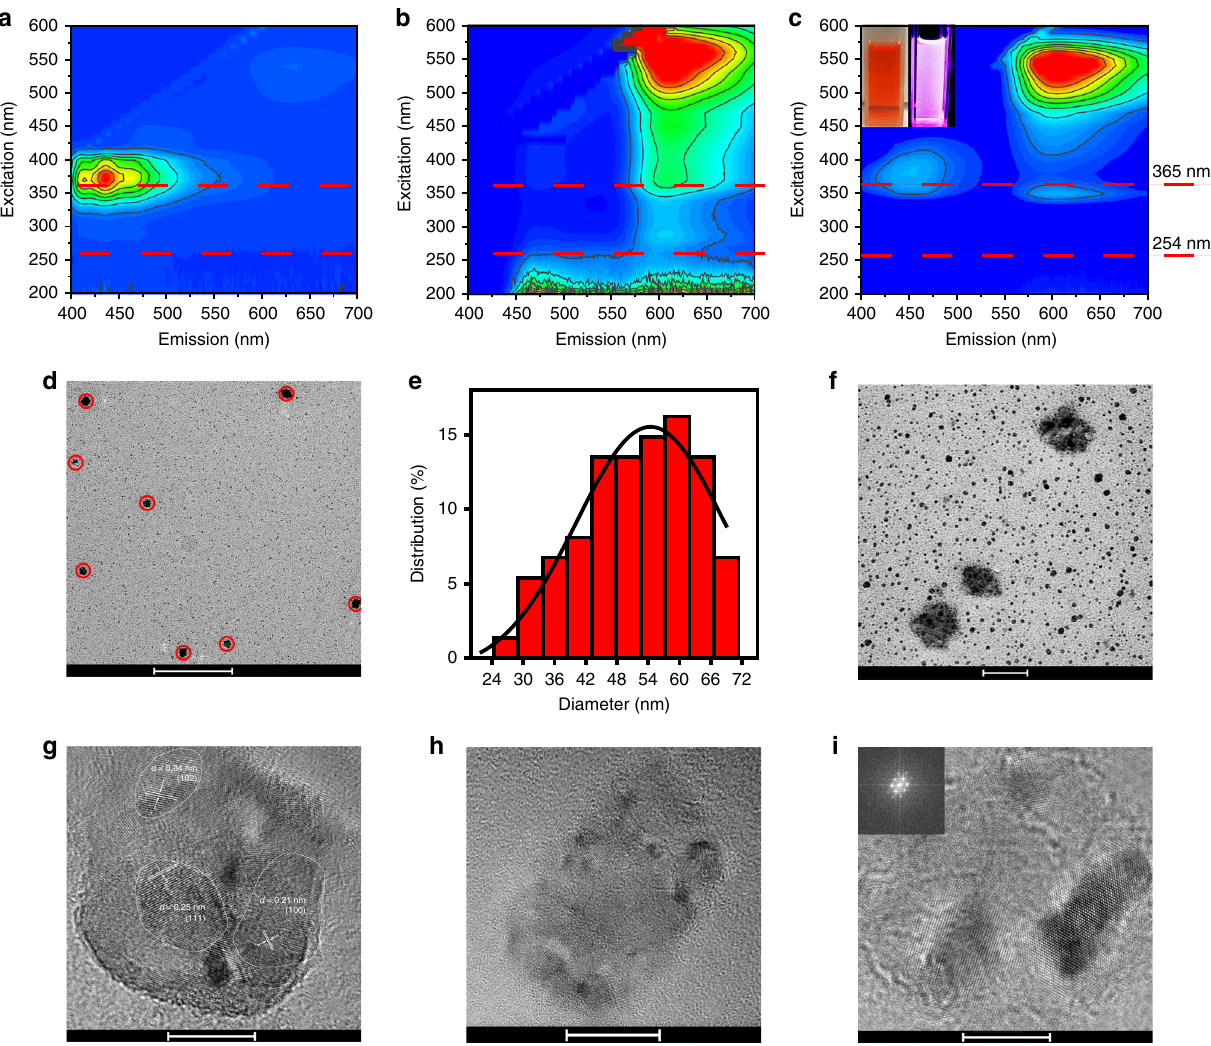
Fig. 5 Different fl uorescence and morphology of H-CDs in varying state. PL mapping spectra of a the H-CD powder acetic acid solution, b H-CD powder and c the H-CD powder DMF solution (insets: photos of the H-CD DMF solution under white light (left) and 365 nm (right) irradiation, dash line marks out emission under 365 or 254 nm UV). d , f TEM image and e particles size distribution of H-CD aggregates (marked by red circles) in the DMF solution. g – i High-resolution TEM (HR-TEM) image of the H-CD aggregates in the DMF solution, inset: FFT diffraction pattern of carbon lattice. Scale bars: 500 nm ( d ), 50 nm ( f ), 20 nm ( h ) and 10 nm ( g , i ). H-CD, hydrophobic carbon dot, TEM transmission emission axisymmetric heterocycles shown in Supplementary Fig. 2 suffer from the restriction of intramolecular rotation (RIR) of symmetrical heterocycles about their disul fi de bonds axes, like other reported symmetrical molecules with AIE 17,18,50 , resulting in red AIE 15,16,51 . Fig. 6b. The square frames in Fig. 6b represent the fi lter paper, the wavy lines represent the paper ’ s fi bers. Blue dots represent the H- CD monomers dispersed in the fi lter paper due to the restriction of the paper ’ s fi bers. As mentioned above, H-CD monomers cannot be excited at 254 nm but can be excited at 365 nm. When water is introduced, some of the H-CD monomers aggregate and paper. Under white light, it is almost colorless and shows a blue fl uorescence under 365 nm UV excitation. At 254 nm the UV surface. Furthermore, the other monomers remain joint to the fi bers. Therefore, under 365 nm irradiation, both the monomers irradiation cannot produce any fl uorescence, which conforms to in the fi lter paper and the aggregates on surface can be excited to the PL property of the H-CD monomers shown in Fig. 5. By glow blue and red emission, which display as a hybrid pink adding water and air-drying, its fl uorescence under 365 nm UV fl uorescence. While under 254 nm irradiation, the monomers are turns to pink. Furthermore, it appears as a red fl uorescence, not excited further, resulting in the red emission only. Once which suggests the H-CDs on the fi lter paper contains both H-CD monomers and H-CD aggregates, compared with the former data. With the addition of ethanol and air-drying, the has been taken to show this reversible process (Supplementary liquid H-CD displays the same optical properties as the H-CD